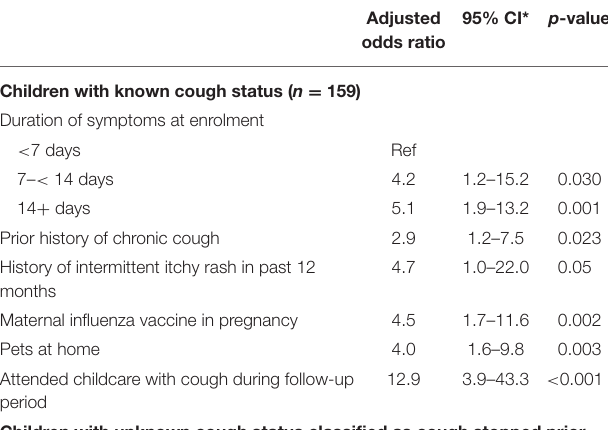
TABLE 2 | Predictors of the presence of chronic cough at day-28 following presentation for an ARI with cough in children aged < 6-years (excluding children for whom cough status at day-28 was unknown), n = 274.